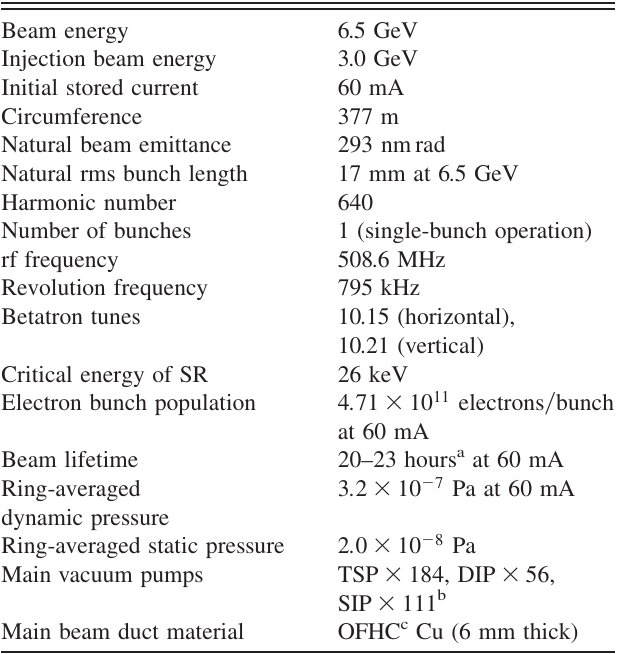
TABLE I. Principal parameters of the